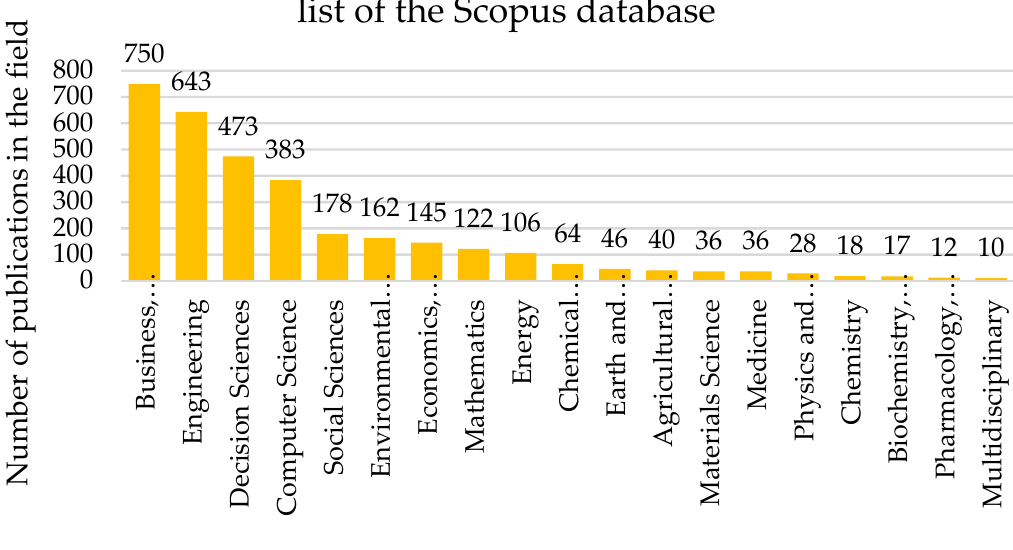
Figure 2. The emergence of disciplines in publications (Source: Self-edit).